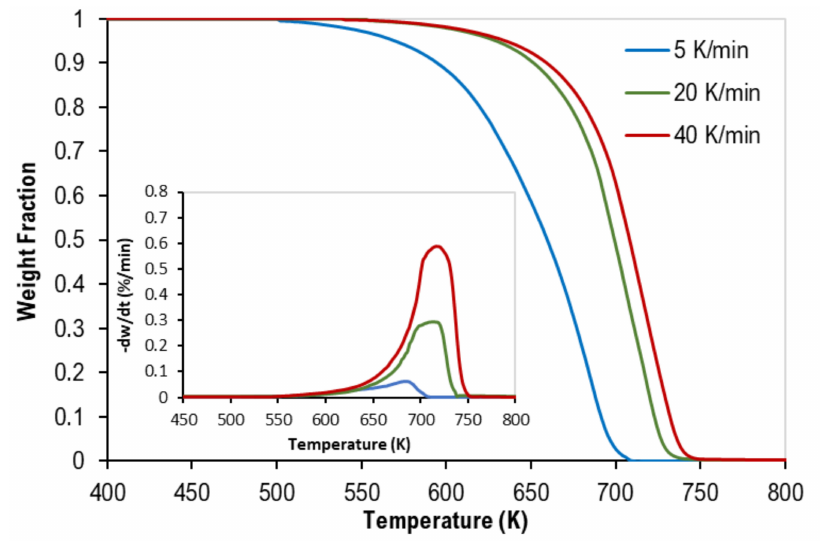
Figure 1. Thermogravimetric (TG) curves of equi-mass binary mixtures of PP and PS (Tests 1–3). Inset: corresponding derivative thermogravimetric (DTG)